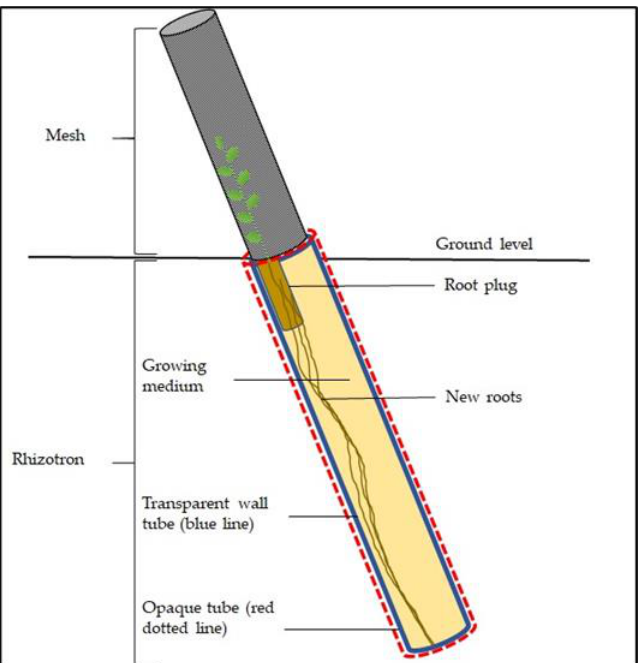
Figure 1. Illustration of a rhizotron used for measuring root growth dynamics under controlled two light conditions.